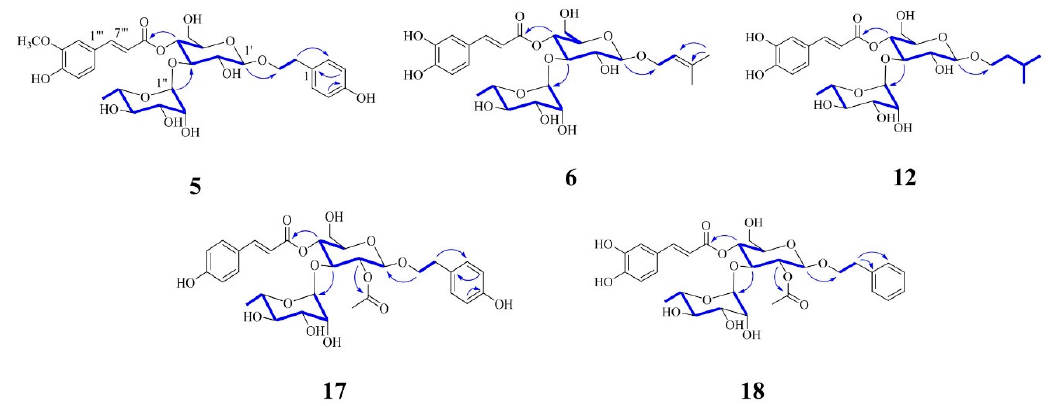
Figure 4. Key 1 H- 1 H COSY ( bold line ) and HMBC ( blue arrow ) correlations of new compounds.